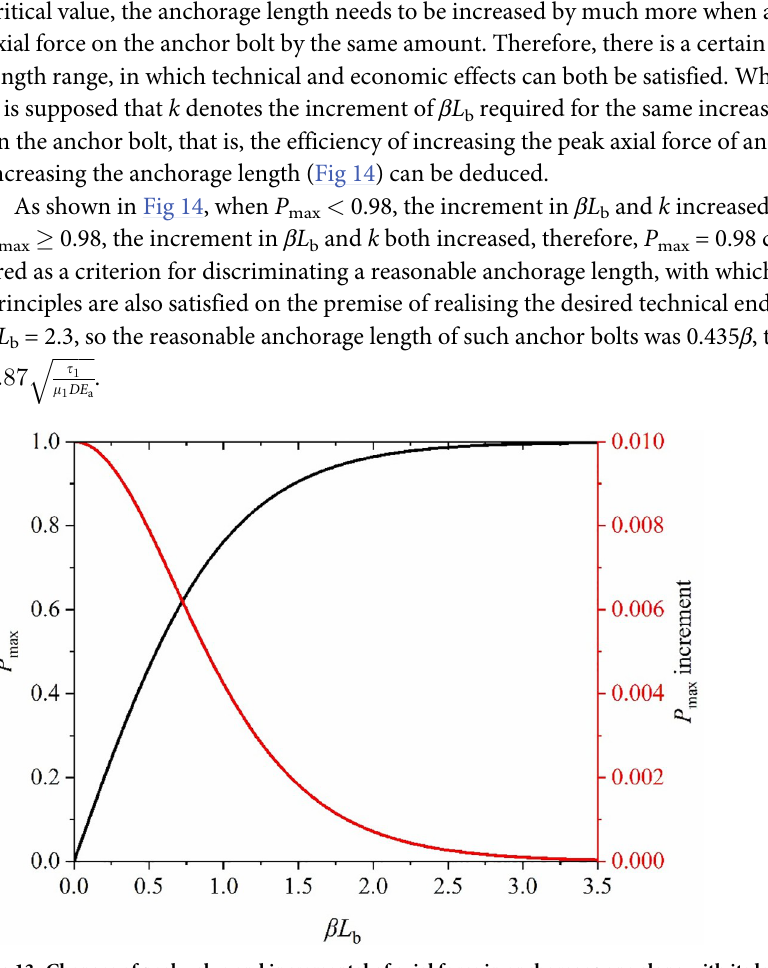
Fig 13. Changes of peak value and incremental of axial force in anchorage zone along with its length.